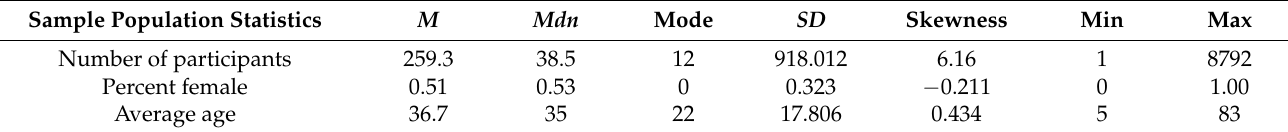
Table 2. Statistical summary of participant sample characteristics ( n = 252 articles